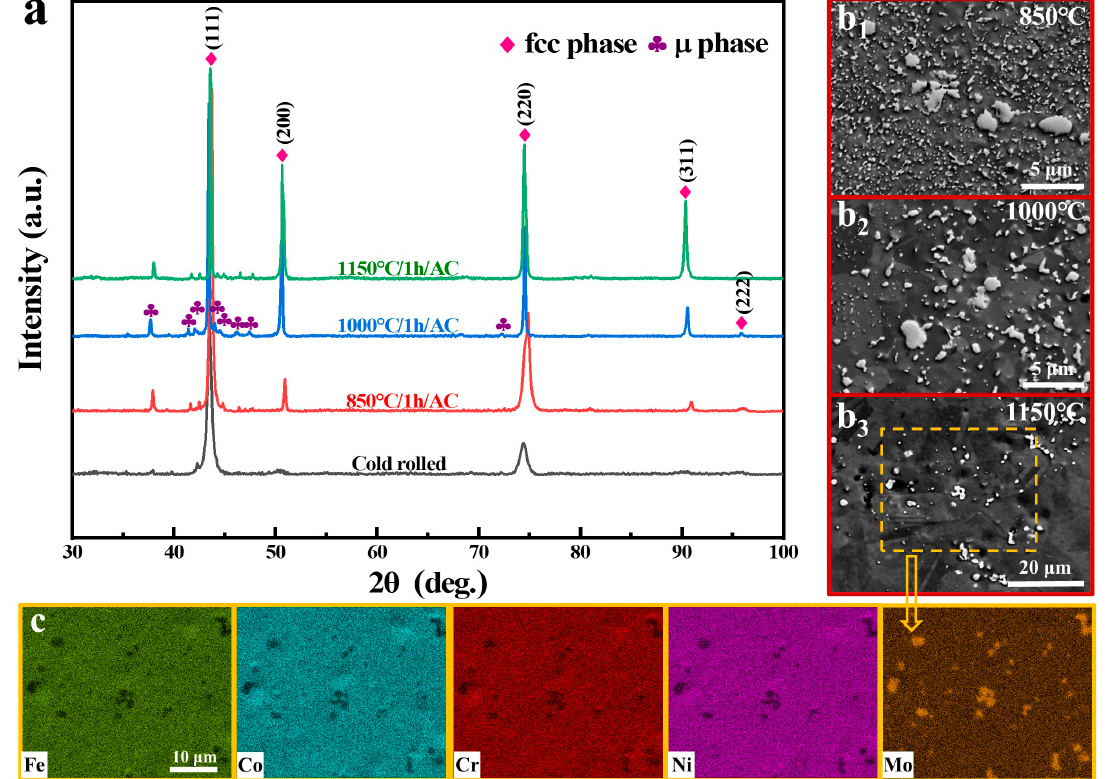
Figure 3. ( a ) The XRD patterns of the Mo 10 HEA in the CR and different annealing conditions; ( b 1 – b 3 ) BSE images of the 850 °C, 1000 °C, and 1150 °C − annealed samples. ( c ) EDS maps of the five elements corresponding to the rectangular area in Figure 3b 3 .